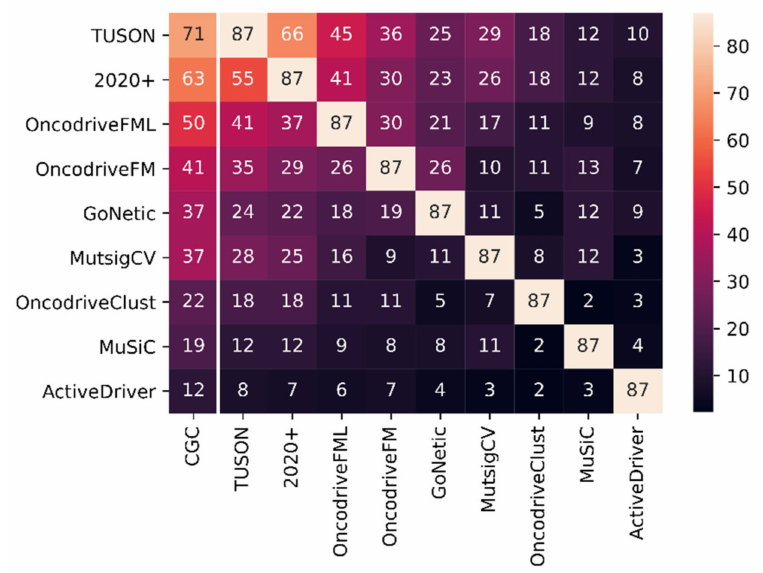
Figure 3. CGC benchmark heatmap between methods. Left-most column: intersection between the top 87 genes identified by each method and CGC. Upper triangle: intersection of the top 87 genes between methods. Lower triangle: intersection between the CGC genes in the top 87 genes between